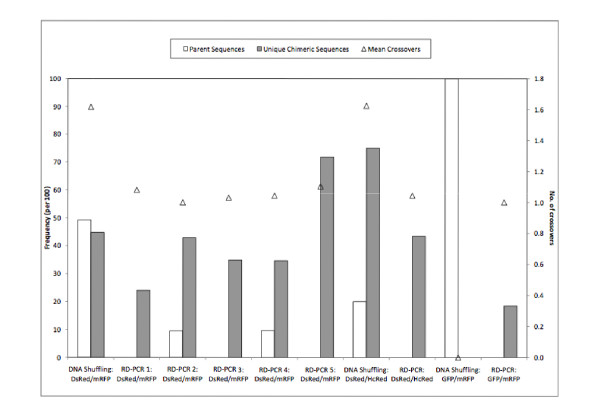
Statistical analysis of the libraries generated by each protocol for DsRed/mRFP and GFP/mRFP. Useful sequences are sequences that would be interesting to screen. This measure excludes parental background and does not count duplicate sequences more than once. RD-PCRs 1–4 use one skew primer per parent (Figure 1b), RD-PCR 5 uses two skew primers per parent (Figure 1c). Templates (see Figure 2): RD-PCR1 and RD-PCR 5: full length DsRed/mRFP. RD-PCR 2: DsRed template with the first 5 bp truncated, full length mRFP. RD-PCR 3: DsRed template with 44 base pairs truncated from the 5' end, full length mRFP. RD-PCR 4: Both templates are truncated. RD-PCR 5: with two skew primers per parent.